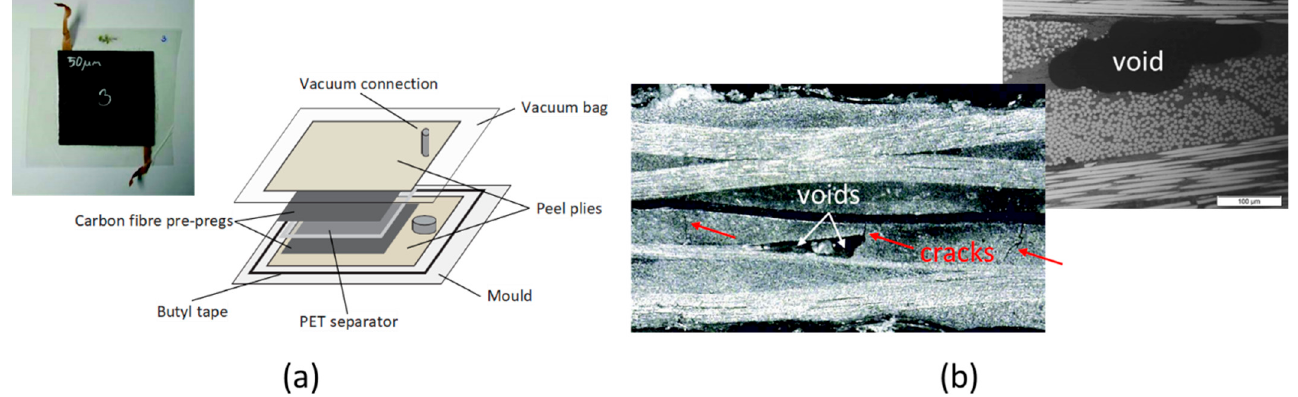
Figure 10. Manufacturing process with a vacuum bag and low-temperature curing ( a ), voids observed after the manufacturing process and possible interaction with cracks during the loading ( b ), adapted from [75].